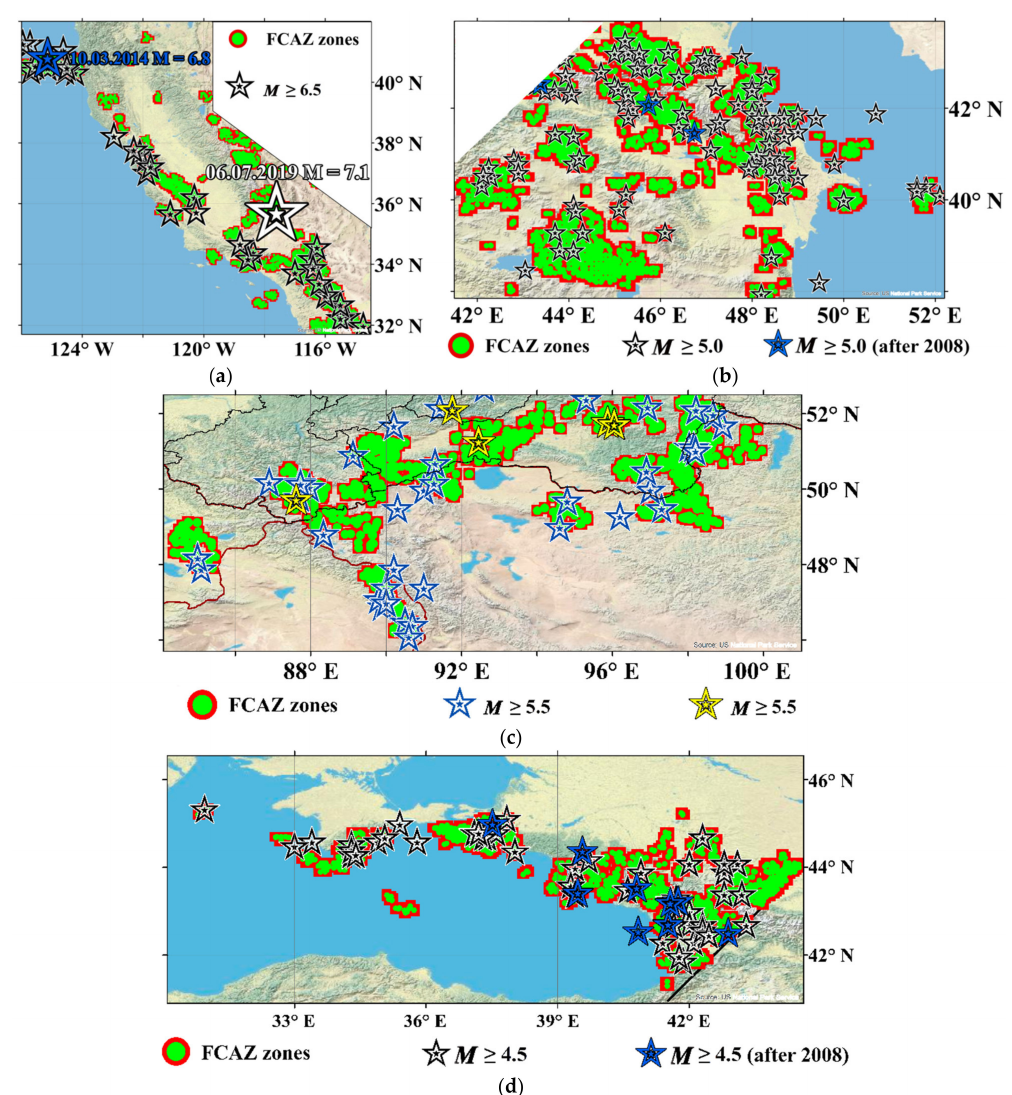
Figure 9. FCAZ zones prone to earthquakes: ( a ) California, M ≥ 6.5 (black stars—epicenters of earthquakes with M ≥ 6.5 from 1836 through 2010; blue and white stars— M ≥ 6.5, since 2014); ( b ) the Caucasus, M ≥ 5.0 (black stars– M ≥ 5.0 for the period of 650–2008; blue stars— M ≥ 5.0, since 2009); ( c ) the Altai–Sayan region, M ≥ 5.5 (blue stars— M ≥ 5.5 for the period of 1902–2008; yellow stars— M ≥ 5.5, since 2011); ( d ) Crimea and the northwestern Caucasus, M ≥ 4.5 (black stars— M ≥ 4.5 for the period of 1900–2008; blue stars— M ≥ 4.5, since